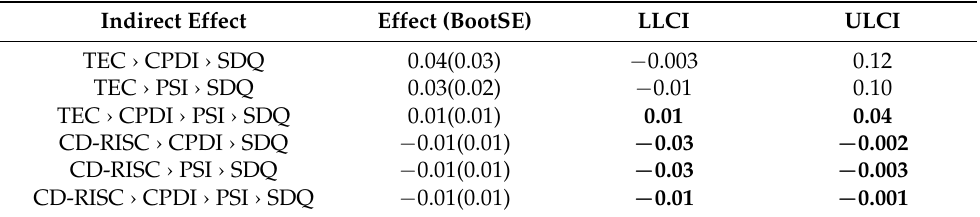
Table 3. Indirect effects of parents’ traumatic experiences and resilience on children’s difficulties through parent’s peritraumatic distress due to COVID-19 and parenting